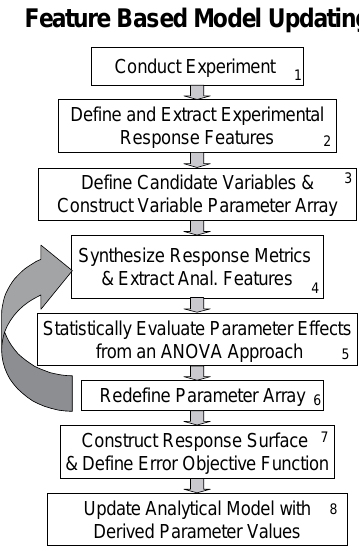
Fig. 1. Model updating method overview.